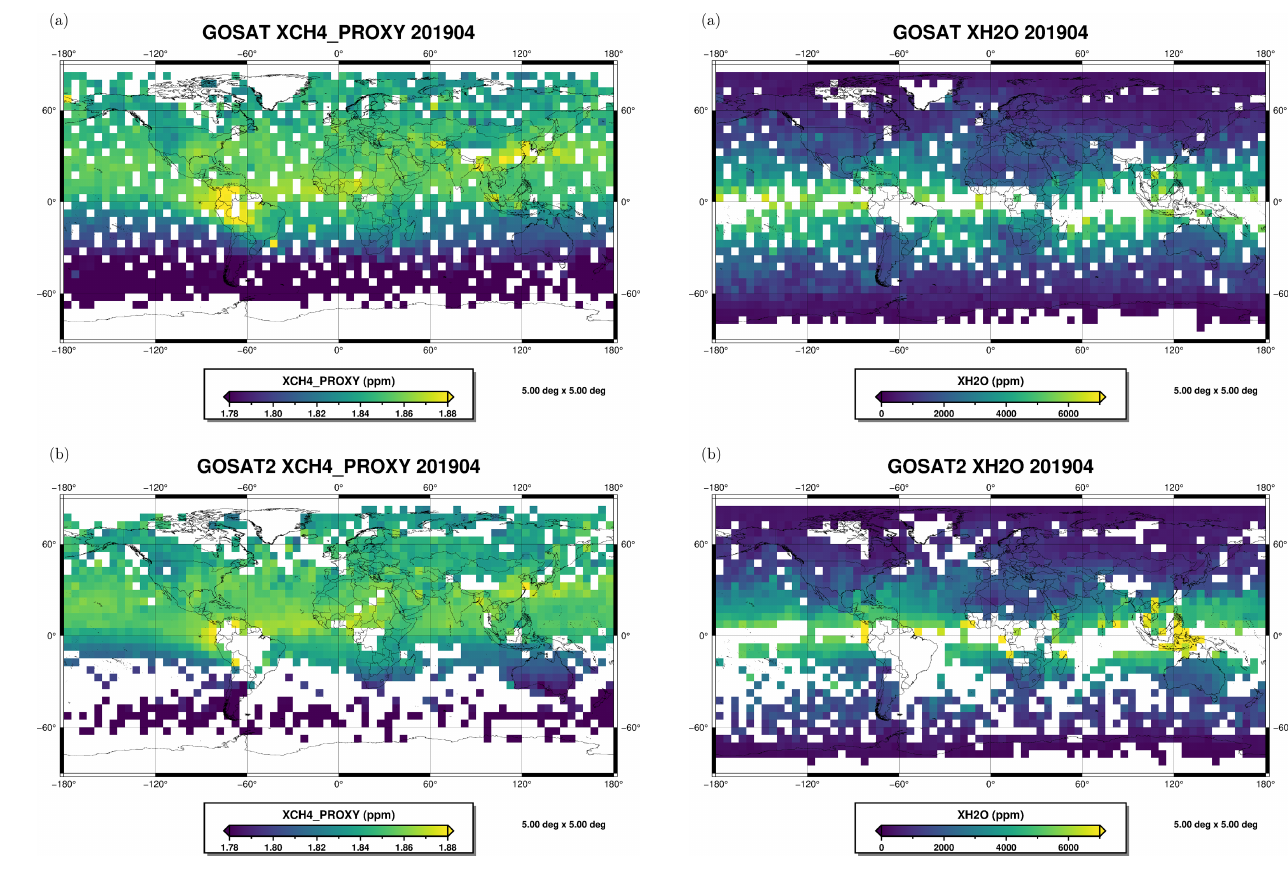
Figure 5. Maps of gridded XCH 4 Proxy data for April 2019: (a) GOSAT; (b) GOSAT-2.